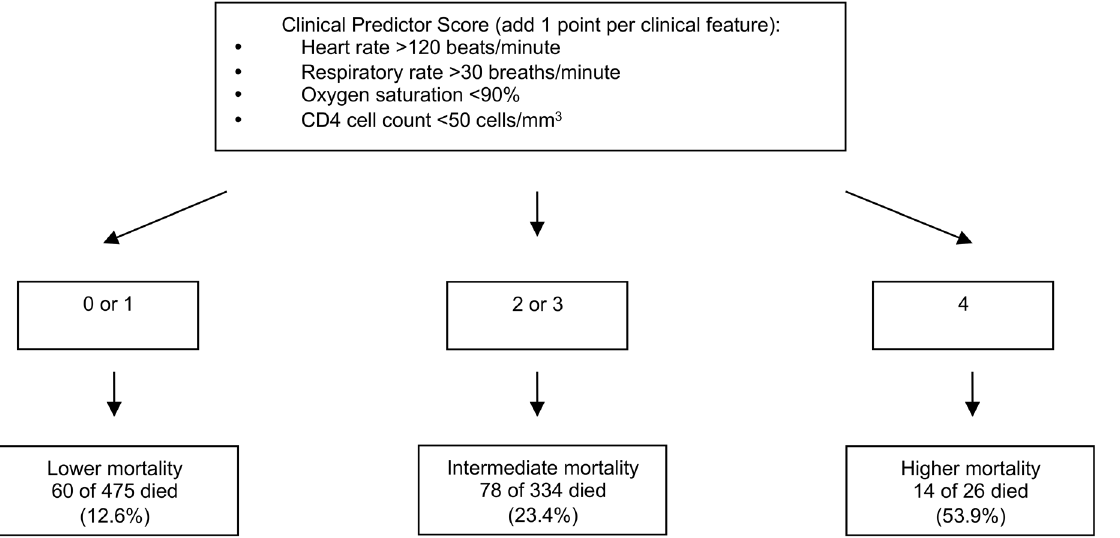
Fig 3. Stratification of patients ’ 30-day risk of mortality based on clinical predictor